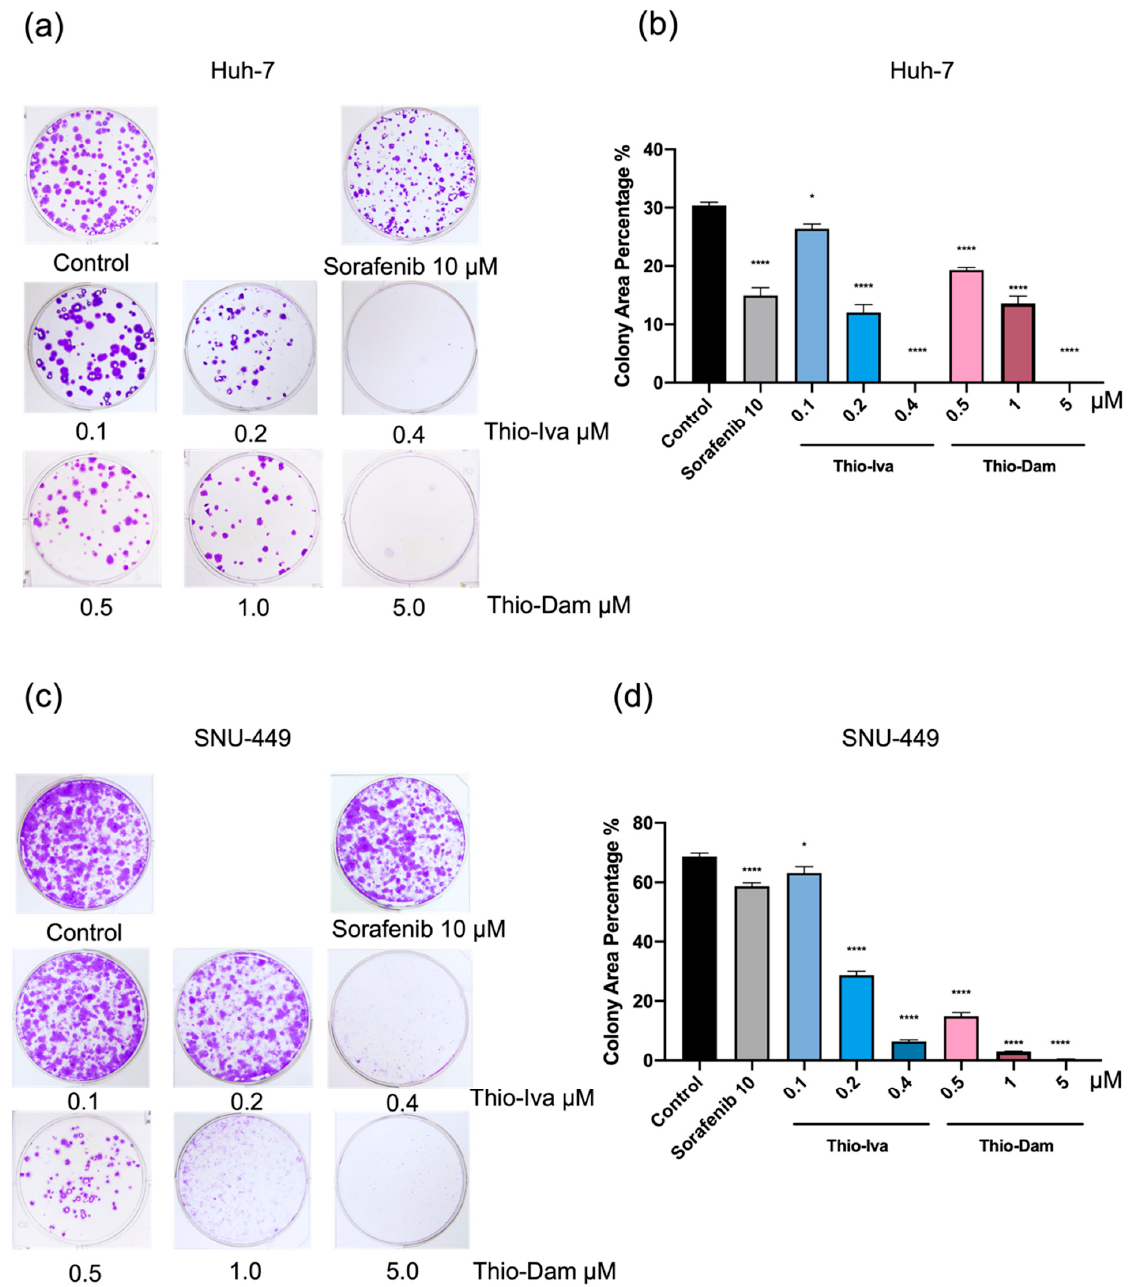
Figure 4. Clonogenic growth. Treatment of Huh-7 ( a , b ) and SNU-449 cells ( c , d ) with Thio-Iva, Thio- Dam, and sorafenib. The percentage of area occupied by the colonies was quantified using ImageJ software 14 days after plating. * p < 0.05 and **** p < 0.0001 by ordinary one-way ANOVA compared to control (untreated). All results were expressed as means ± SEM of ≥ 3 independent experiments.